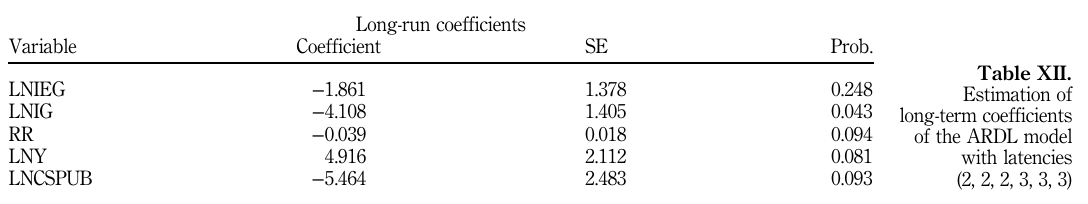
Table XII. Estimation of long-term coefficients of the ARDL model with latencies (2, 2, 2, 3, 3, 3)